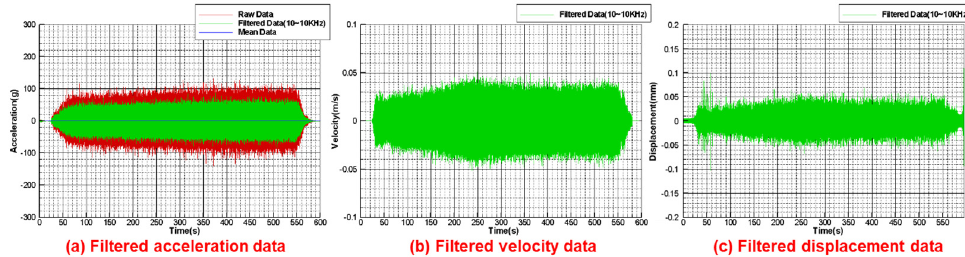
Figure 18. Acceleration, velocity, and displacement of LOx pump with high nose.